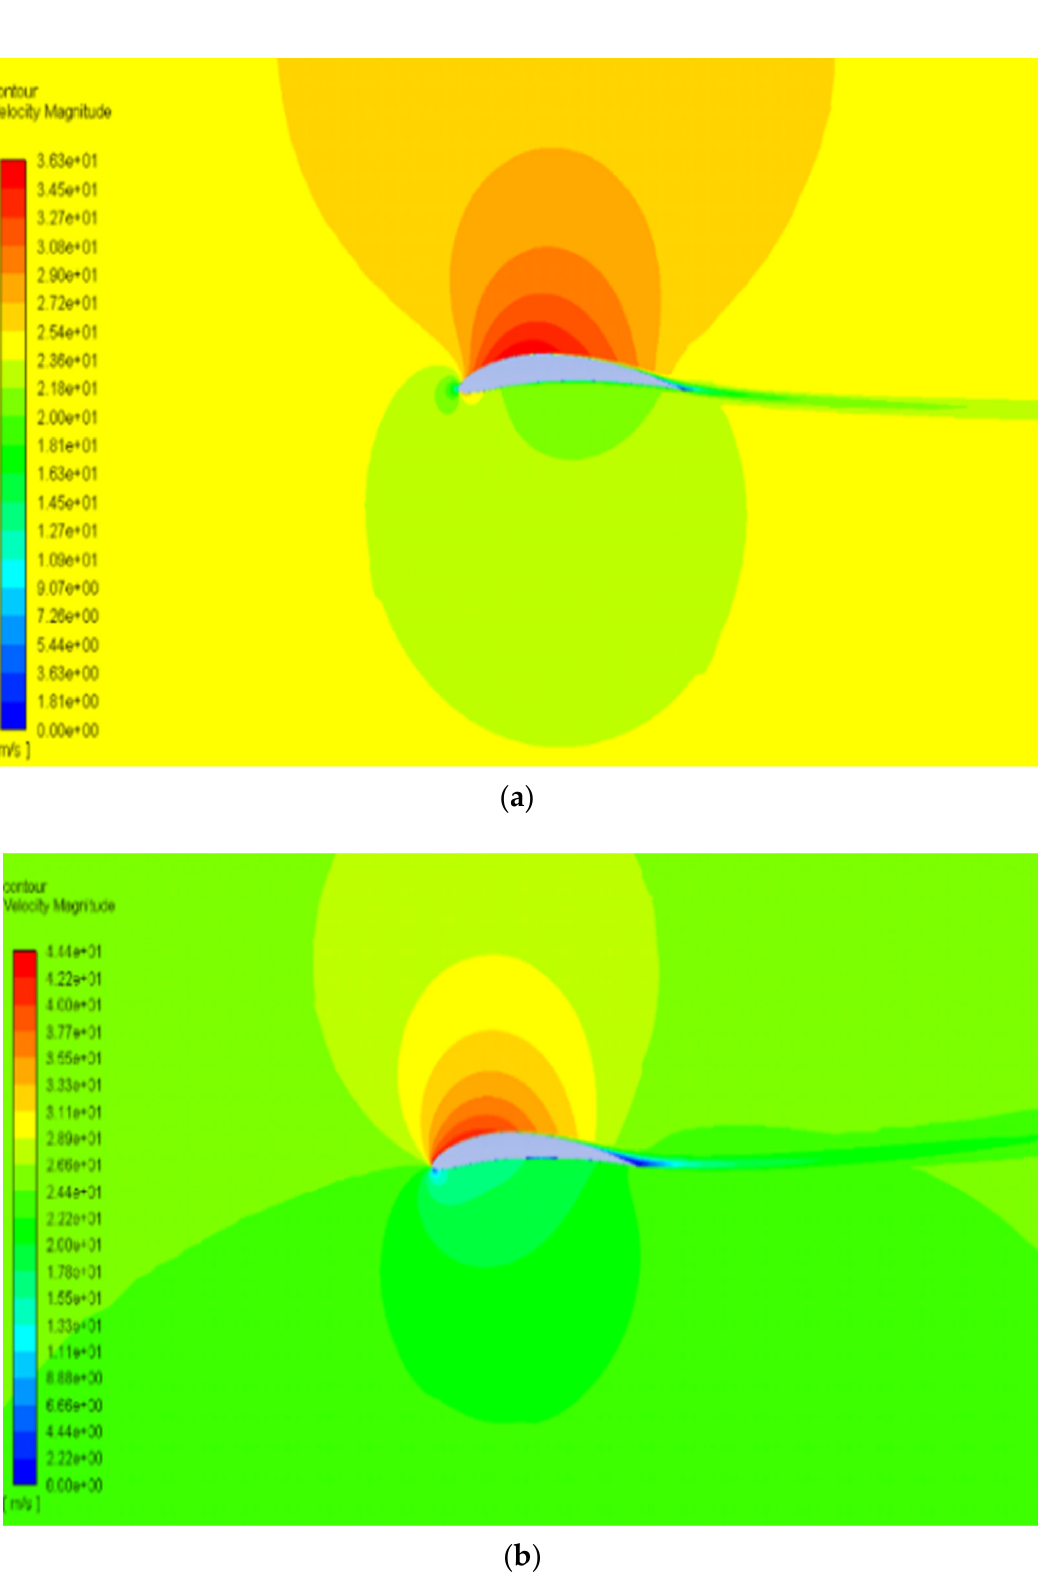
Figure 13. Velocity contour of NACA8410 with AoA ( a ) 1° and ( b ) 8°. The effects of turbulent kinetic energy, k are also explored by generating turbulent kinetic energy, k contours for the AoA of 1 ◦ and 8 ◦ , as shown in Figure 14. It is also